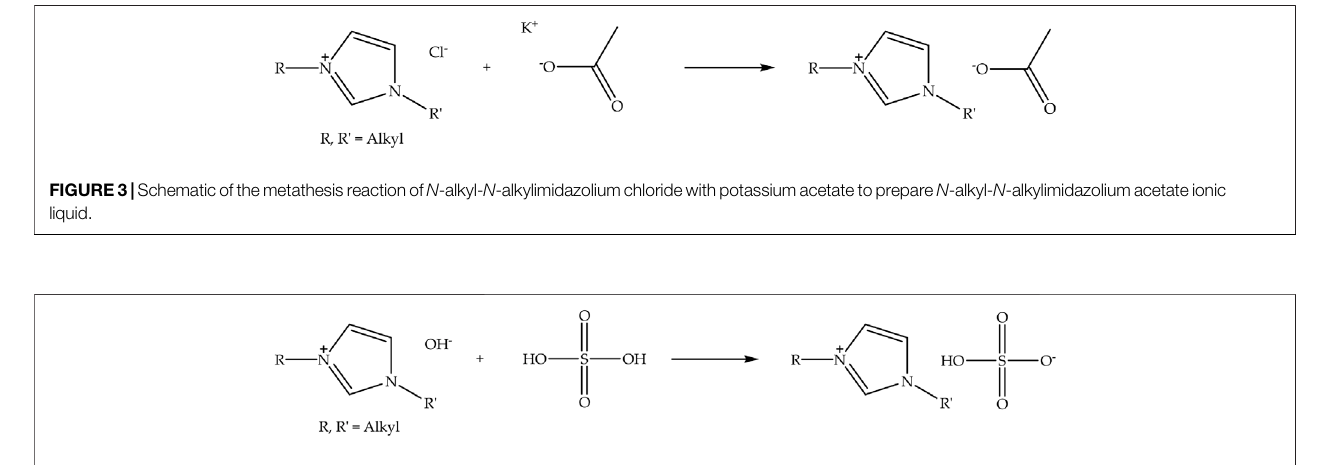
FIGURE 4 | Schematic of the neutralization reaction of N -alkyl- N -alkylimidazolium hydroxide with sulfuric acid to prepare N -alkyl- N -alkylimidazolium hydrogen sulfate ionic